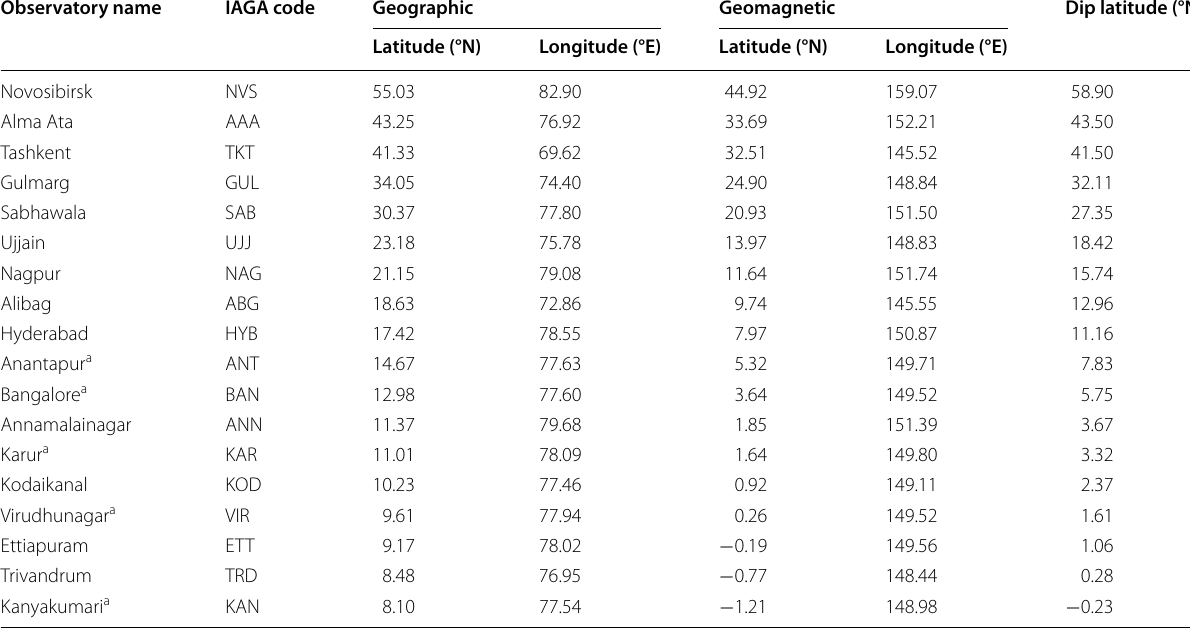
Table 1 List of IEEY and other stations along the Indian sector and their geographic/geomagnetic coordinates and dip